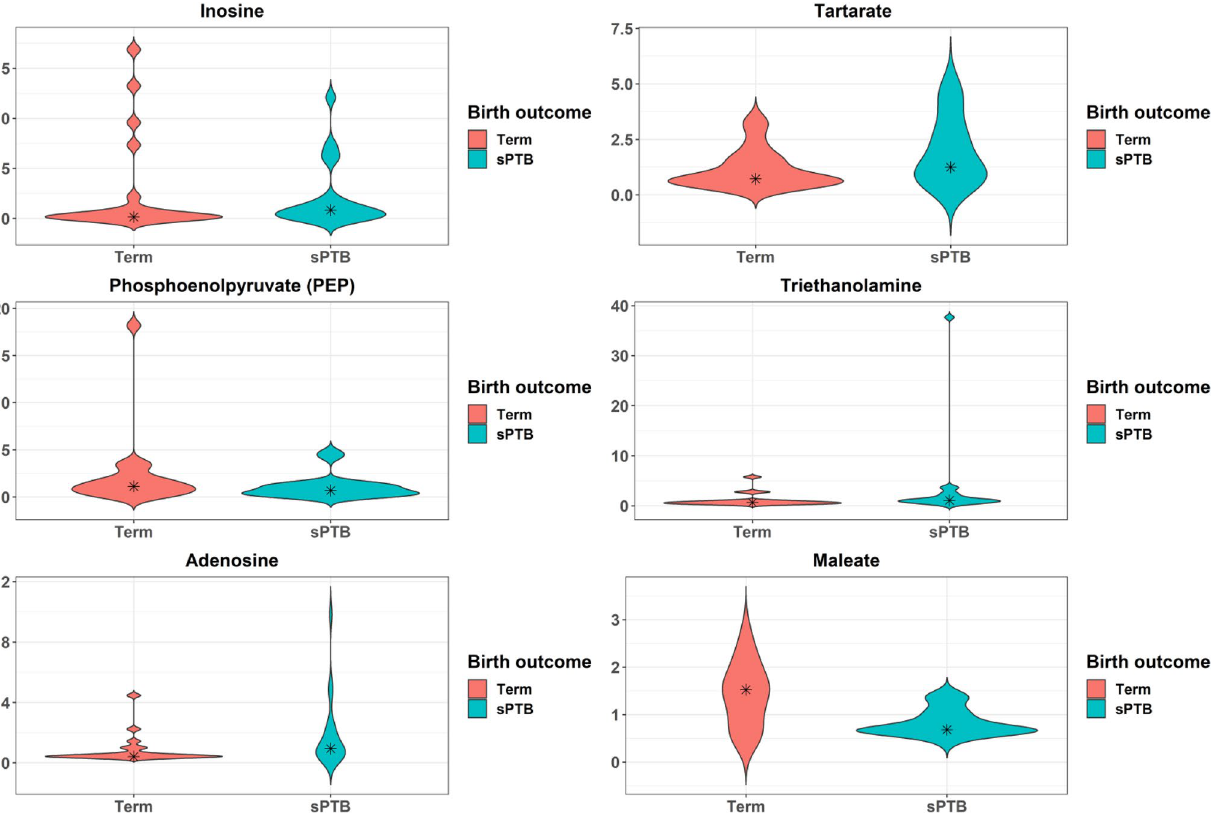
Figure 5. Violin plots of metabolites among CST I that differed by birth outcome. Kernel probability density of various metabolites are presented. Metabolite abundances were log2 transformed and two-sided Student t-tests were performed. Resulting p-values were corrected by false discovery rates calculated using the Benjamini– Hochberg (BH) method with a threshold of ≤ 0.1. Fold change was calculated to quantify the difference in log2 change between groups for each metabolite. Metabolites with a p-value ≤ 0.05 and absolute fold changes ≥ 1.5 were considered significant. Violin plots are presented for the top six metabolites with the greatest fold